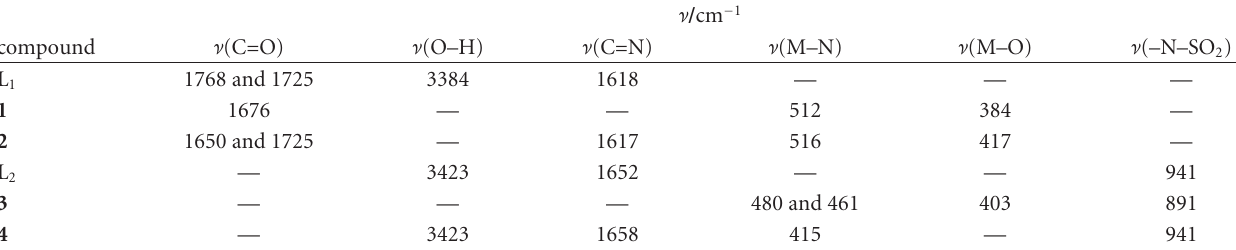
Table 2: Infrared spectral data of the ligands and their organotin(IV) complexes.